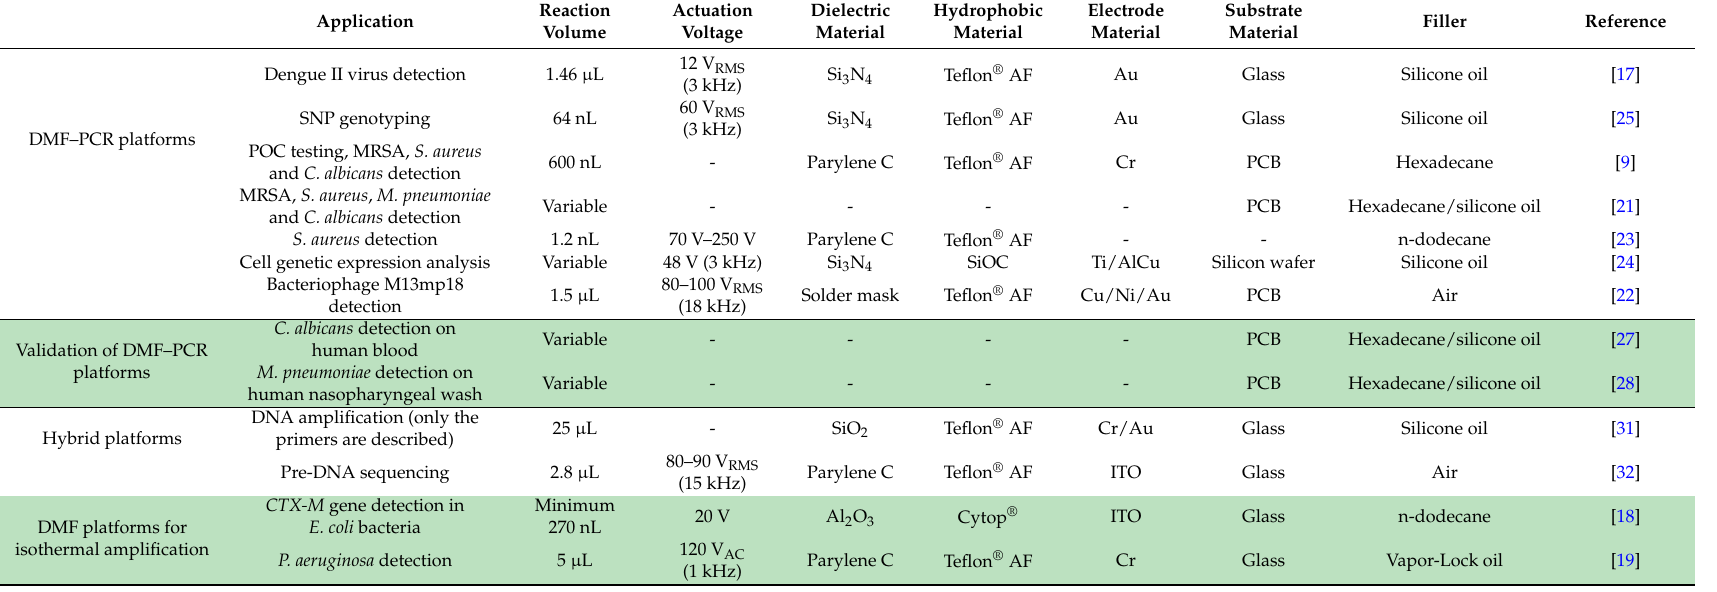
Summary of DMF platforms for nucleic acid